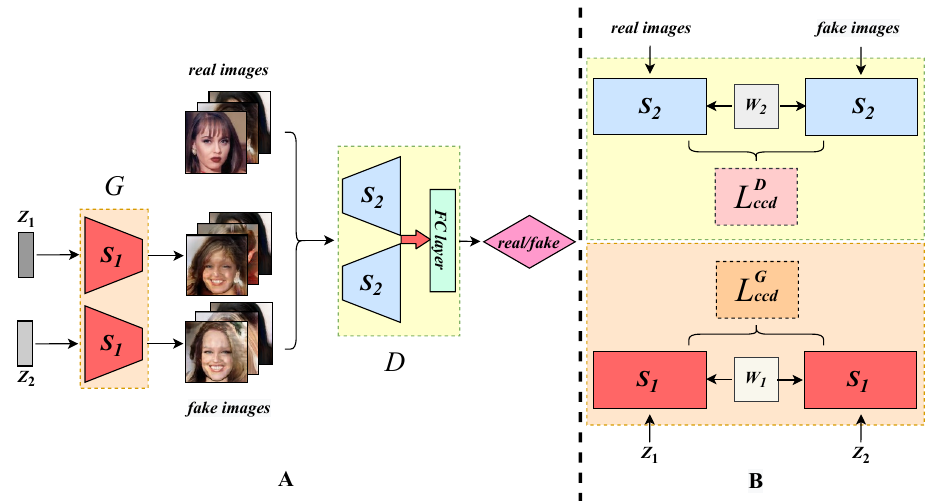
Figure 1. Illustration of the Contrastive Distance Learning-Generative Adversarial Network (CDL- GAN) framework. Part A: the generator, G , consists of a Siamese module, S 1 . The discriminator, D , includes a Siamese module, S 2 , and a fully connected (FC) layer. L G means Consistent Contrastive ccd Distance (CoCD), while L D means Characteristic Contrastive Distance (ChCD). S 1 shares the weights ccd W 1 when noise vector z 1 and z 2 are fed to G . S 2 shares the weights W 2 when real and fake images pass through D